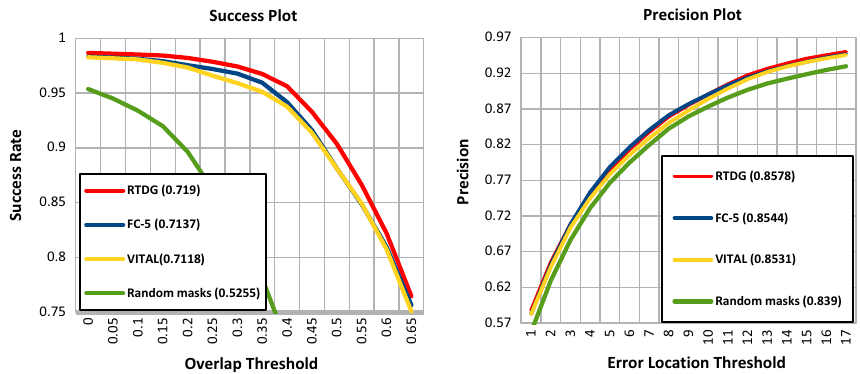
Fig. 5 Ablation Study. Precision and success plots on the OTB‑2015 dataset using OPE